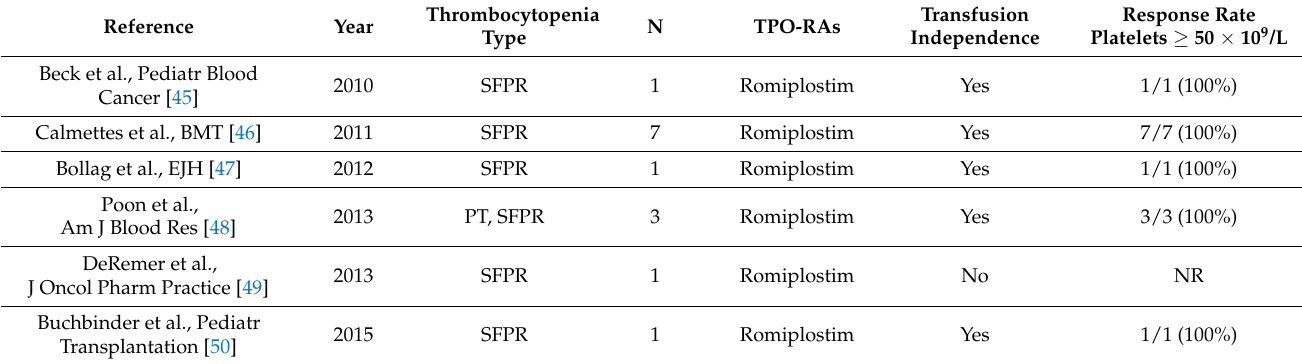
Table 2. Experience with Romiplostim for persistent thrombocytopenia in an allo-SCT